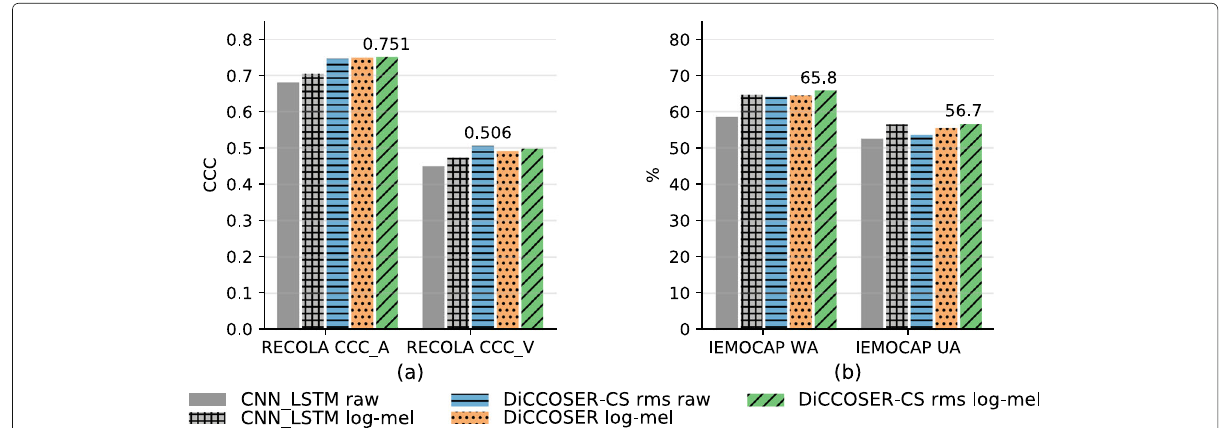
Fig. 7 Comparisons between using raw time domain samples and using log mel-spectrograms as the SER model